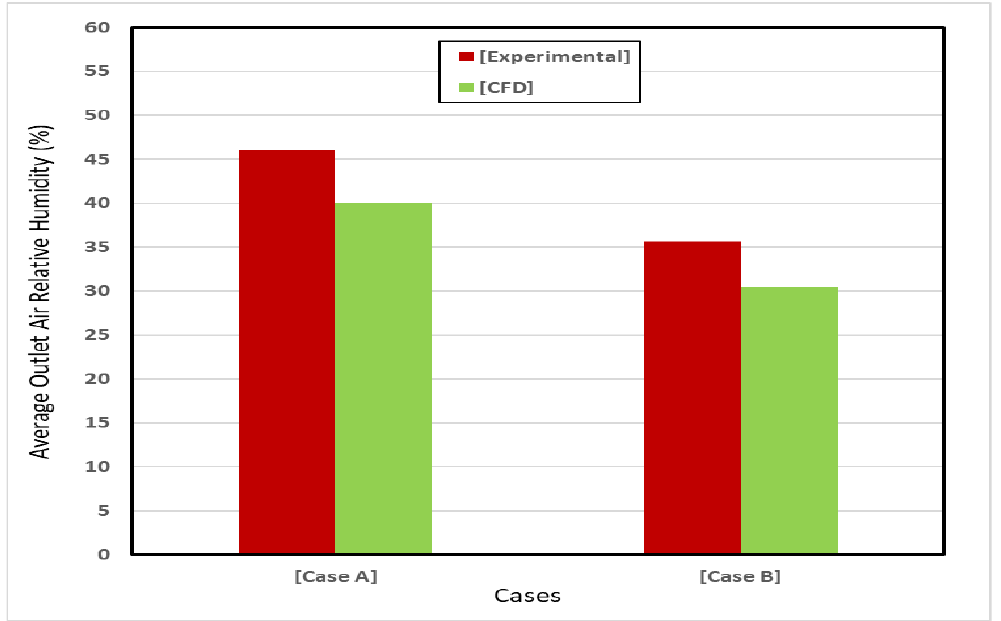
Figure 22. Simulated and experimental average relative air humidity during the experimental period for the tested Case A and Case B FPSAHs.